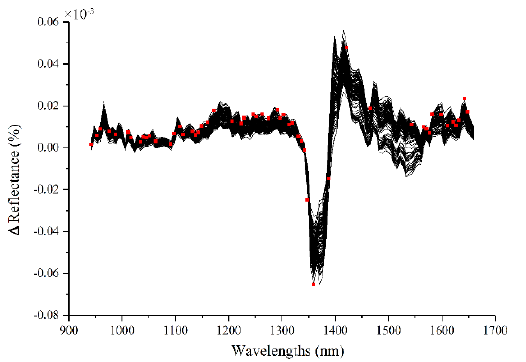
Figure 3. Feature extraction of successive projection algorithm in the available nitrogen content spectra.